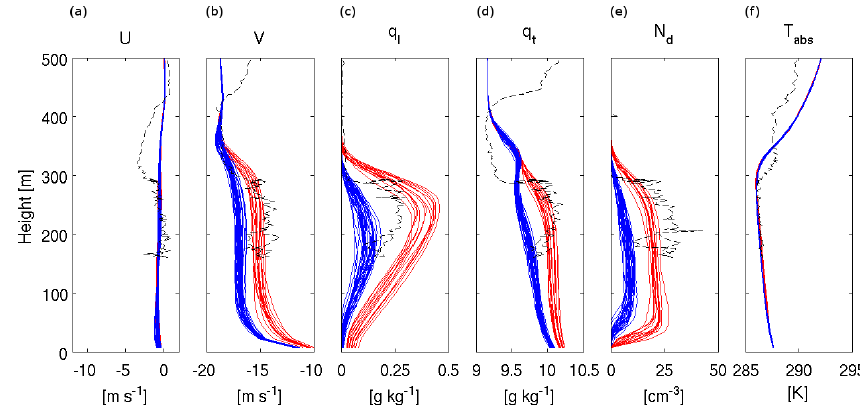
Figure 3. Profiles of y -averaged u and v winds, liquid water mass mixing ratio q l , total water mass mixing ratio q t , absolute temperature T abs , and cloud droplet concentration N d after 8h, immediately before the ship track perturbation is introduced. Profiles are sampled at the locations of mesoscale updrafts (red curves) and downdrafts (blue curves), identified by maxima or minima in the y -averaged liquid water